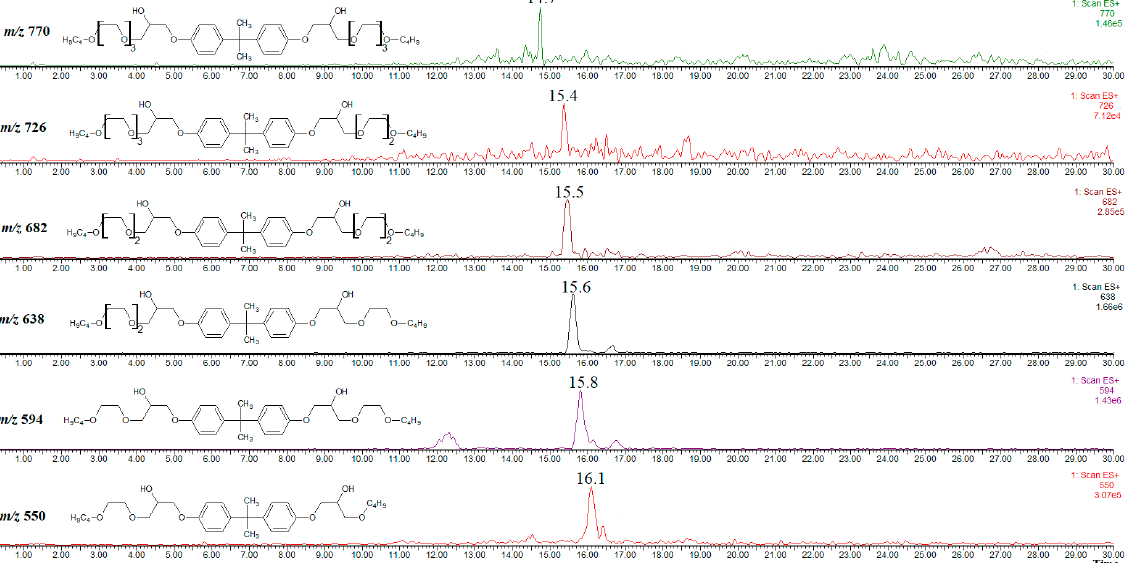
Figure 1. Single ion chromatograms of [M+NH 4 ] + ions of ethoxylated butoxyethanol-BADGE adducts.